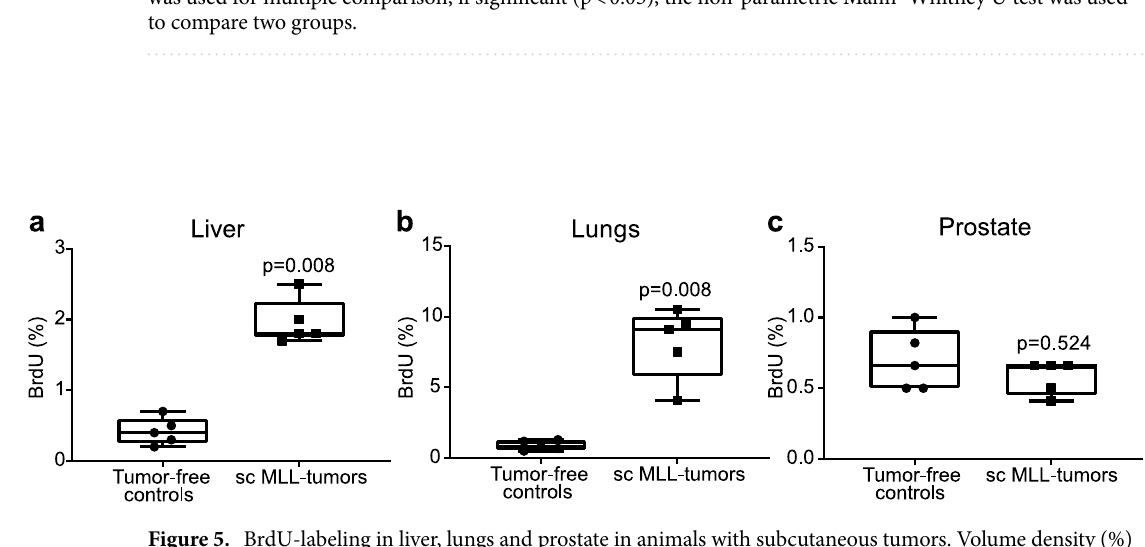
Figure 5. BrdU-labeling in liver, lungs and prostate in animals with subcutaneous tumors. Volume density (%) of BrdU + cells in the liver ( a ), lungs ( b ), and ventral prostate ( c ) in animals with subcutaneous (sc) MLL-tumors and in tumor-free controls. Sc MLL-tumors significantly increased BrdU-labeling in liver and lungs, while notably did not increase BrdU-labeling in the prostate (Mann–Whitney U